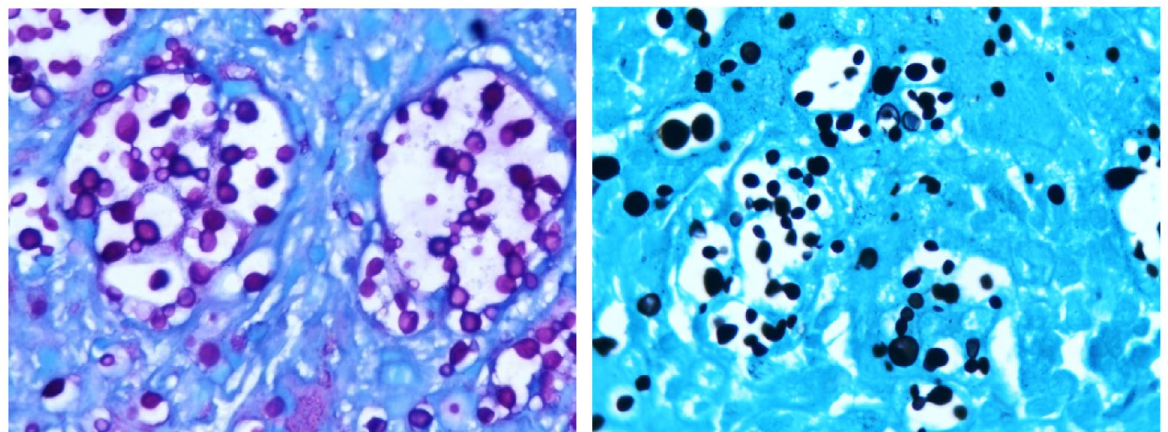
Figure 2: Photomicrograph of lymph node biopsy showing variably sized budding yeast forms of Cryptococcus species highlighted by A) Periodic acid Schiff stain; B) Grocott’s methenamine silver stain. (Histochemistry,